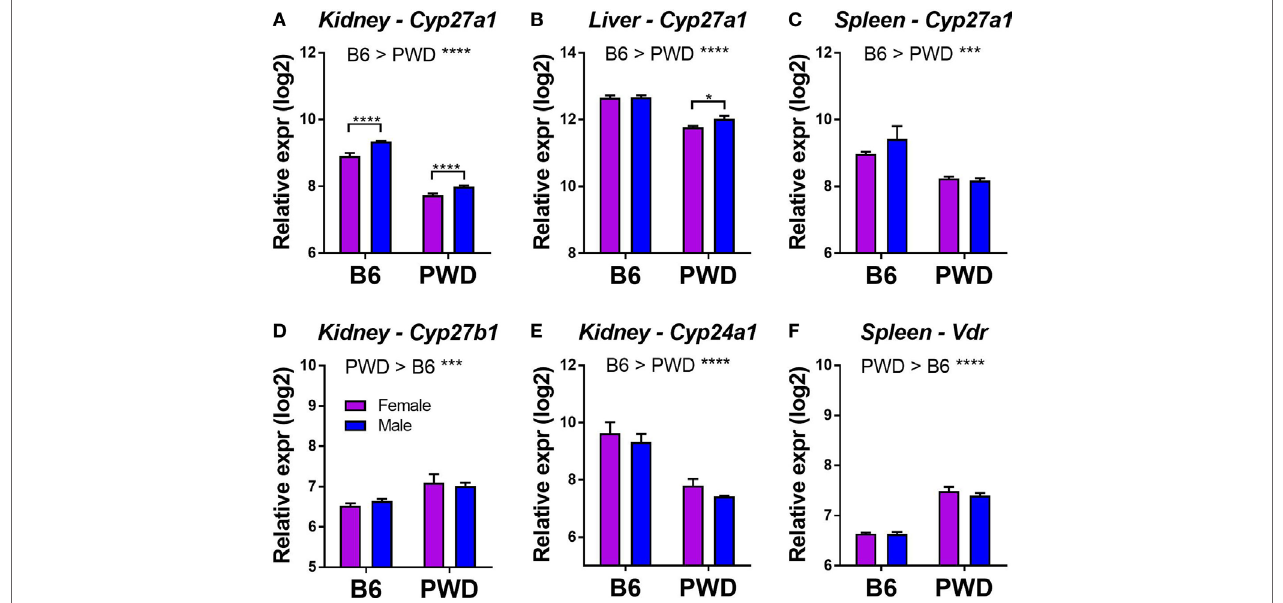
FigUre 6 | Tissue-specific differential expression of vitamin D3 metabolic pathway genes in B6 and PWD mice. Gene expression data were obtained from the Gene Expression Miner database, as described in Section “Materials and Methods.” Genes showing a significant differential expression (with a greater than 30% change in expression) as a function of strain or sex are shown in (a–F) . The significance of the observed differences was assessed by two-way ANOVA, with Holm– Sidak’s post hoc comparisons: B6 vs. PWD (overall effect of strain; indicated above the graphs), and female vs. male (within strain; indicated with brackets). The data included 12 C57BL/6J mice (6 females and 6 males), and 11 PWD/PhJ mice (6 females and 5 males). Symbols indicate a significant difference between the indicated groups, as follows: * p < 0.05; ** p < 0.01; *** p < 0.001; **** p <